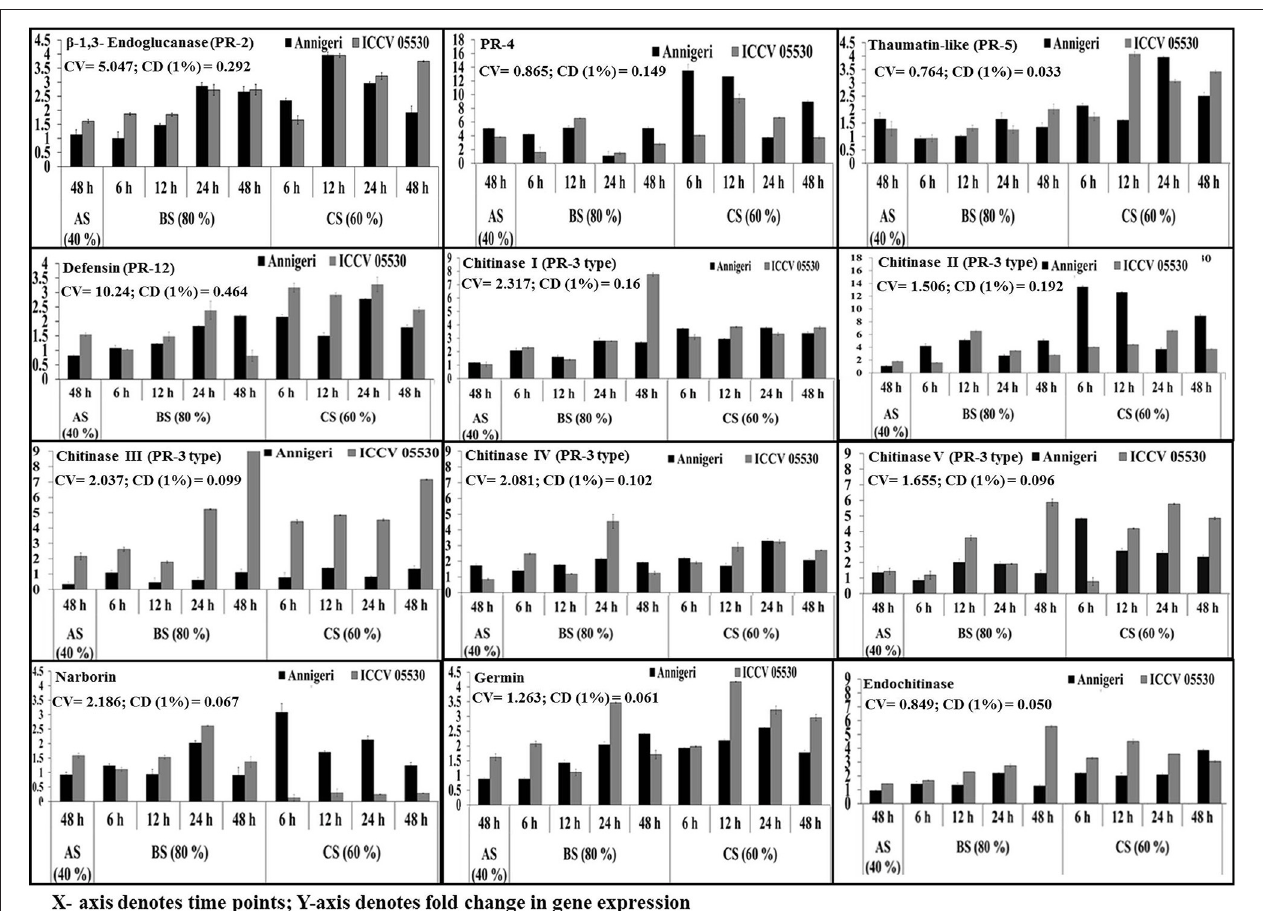
FIGURE 4 | RT-qPCR analysis of different pathogenesis-related genes expressed differentially in chickpea during interaction with S. rolfsii at limiting (40%), lower optimum (60%) and optimum (80%) soil moisture conditions. Time (in hours) and fold change in gene expression are shown on X and Y axis, respectively. Standard error of three biological replications was calculated and represented as error bar. AS, BS, and CS denote abiotic stress, biotic stress, and combined stress respectively. The statistical significance of gene expression in between the control and treated seedlings was calculated by factorial